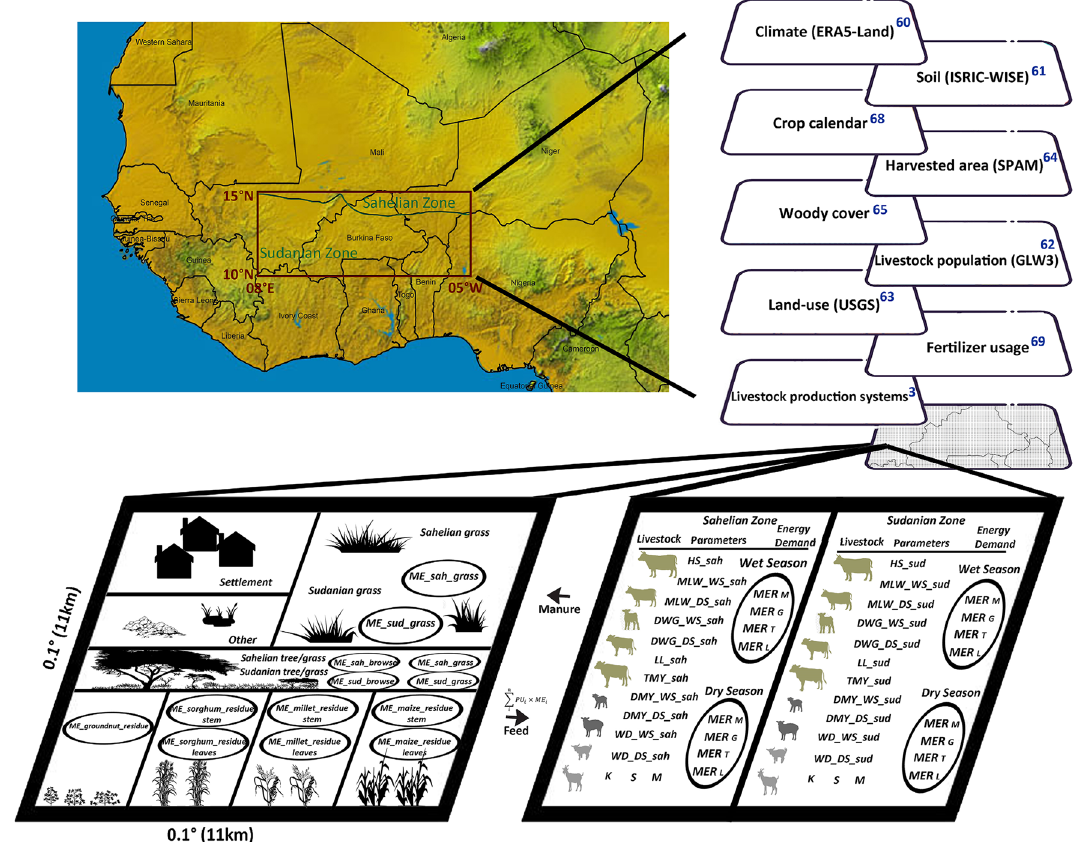
Figure 7. Study area, datasets used, and overview of the methodology employed for modeling energy supply and demand for a grid cell (please refer to Table S.1 in Supplementary Information for a description of each abbreviation used in this figure). Figures were generated using ArcGIS 10.8.1 (https:// www. esri. com/ en- us/ arcgis/ produ cts/ arcgis- pro/ overv iew) and Microsoft PowerPoint 2016 (https:// www. micro soft. com/ de- de/ micro soft- 365/ power